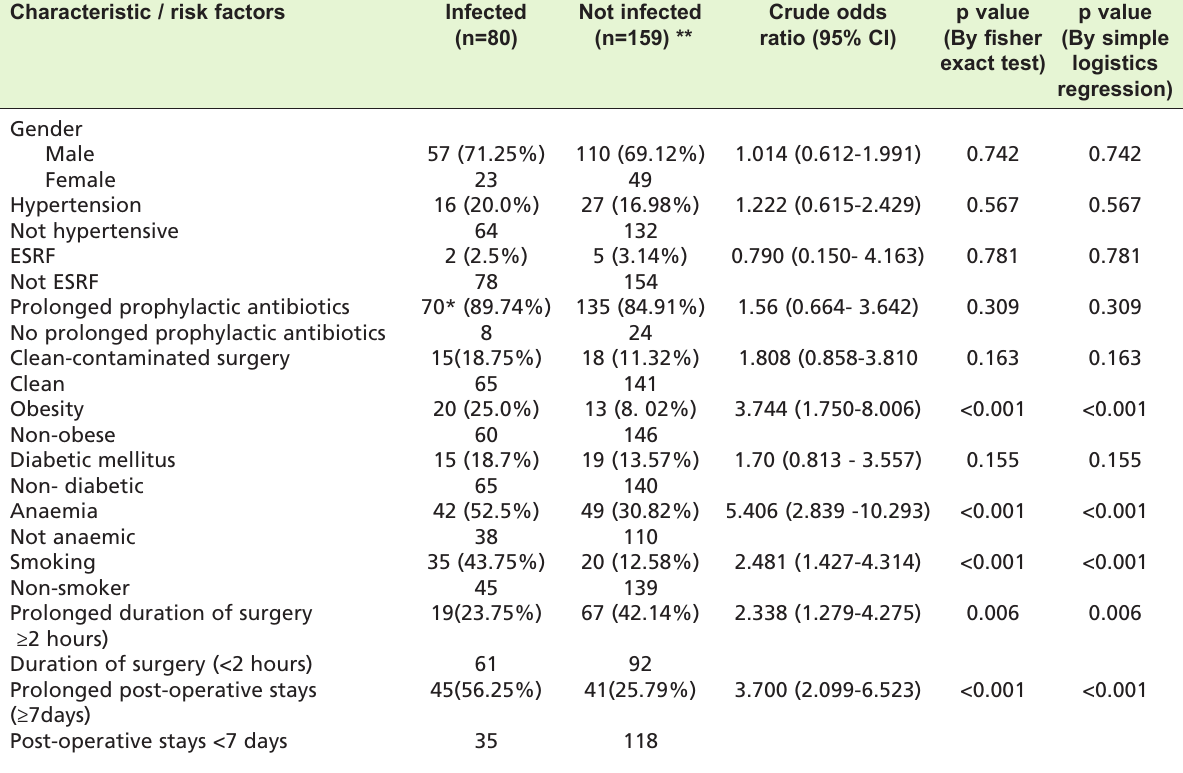
Table I: Risks factors and outcome in patients with orthopaedic SSI by simple logistic regression Characteristic / risk factors